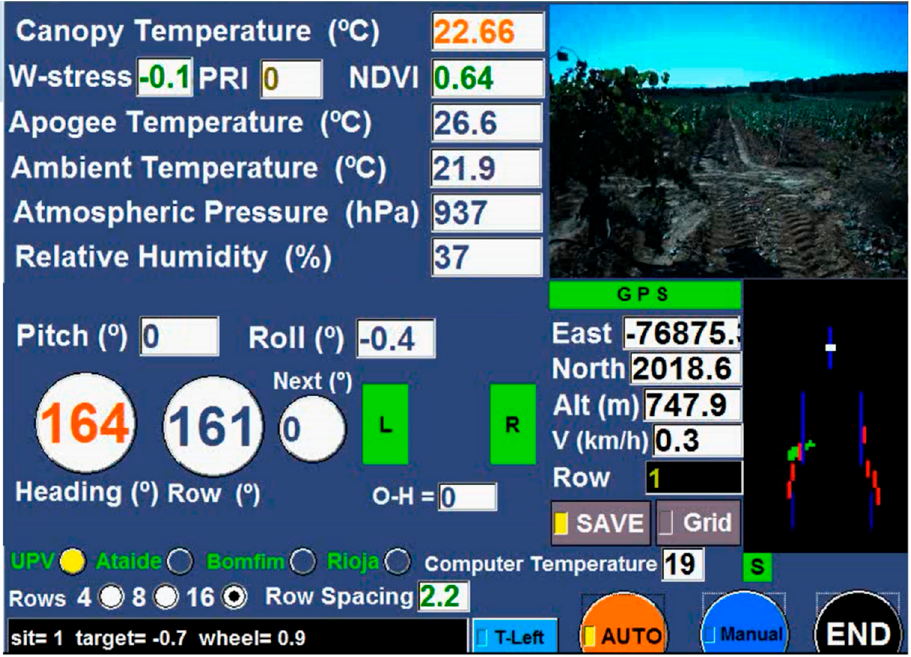
Figure 4. Graphical user interface (GUI) for the VineScout robot.